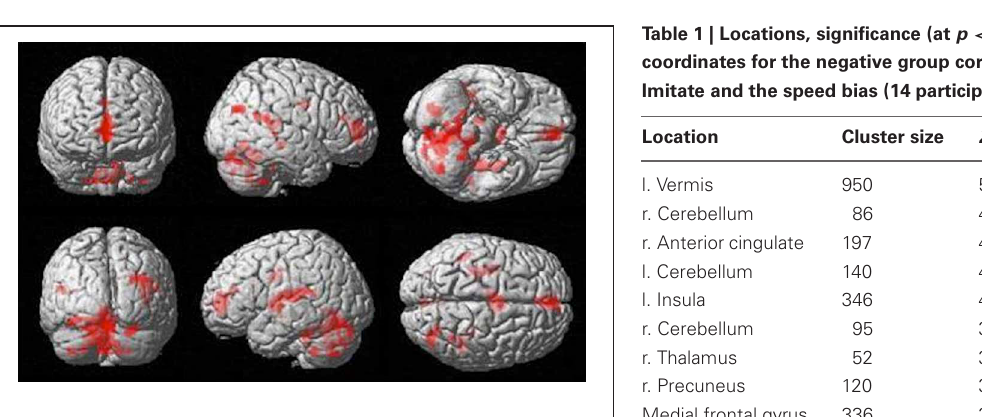
FIGURE 5 | Group activation found in the negative correlation between the BOLD Imitate contrast and rate of change in speed “ m ” (14 participants, p < 0 . 05 FWE-corr.).